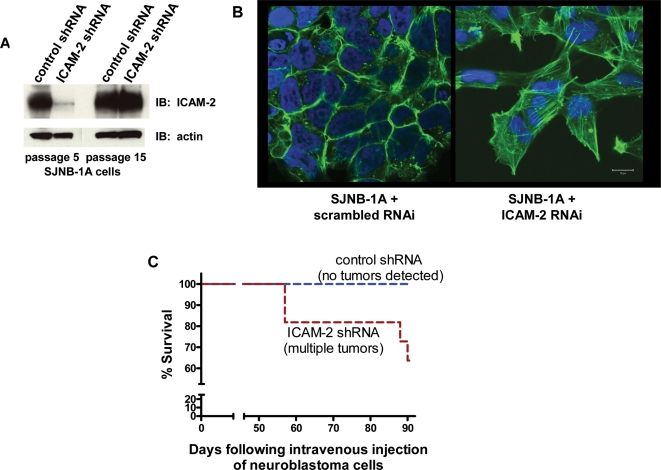
RNAi techniques indicated that the observed ICAM-2-induced phenotype was unlikely to be due to artificial overexpression of this protein.A) SJNB-1A cells express a relatively high endogenous level of ICAM-2 (Fig. 1A). The expression of ICAM-2 was inhibited in a population of SJNB-1A cells transfected to stably express ICAM-2 shRNA. This inhibition was transient even in the presence of selection pressure by G418 in vitro. B) Consistent with the proposed hypothesis, the high endogenous level of ICAM-2 expression in SJNB-1A cells is co-incident with a juxtamembrane distribution of actin fibers (left panel); and when ICAM-2 expression is decreased, actin fibers are transverse (right panel). C) Inhibition of ICAM-2 expression increased the development of disseminated neuroblastoma tumors in SCID mice injected intravenously with SJNB-1A ICAM-2 shRNA cells.